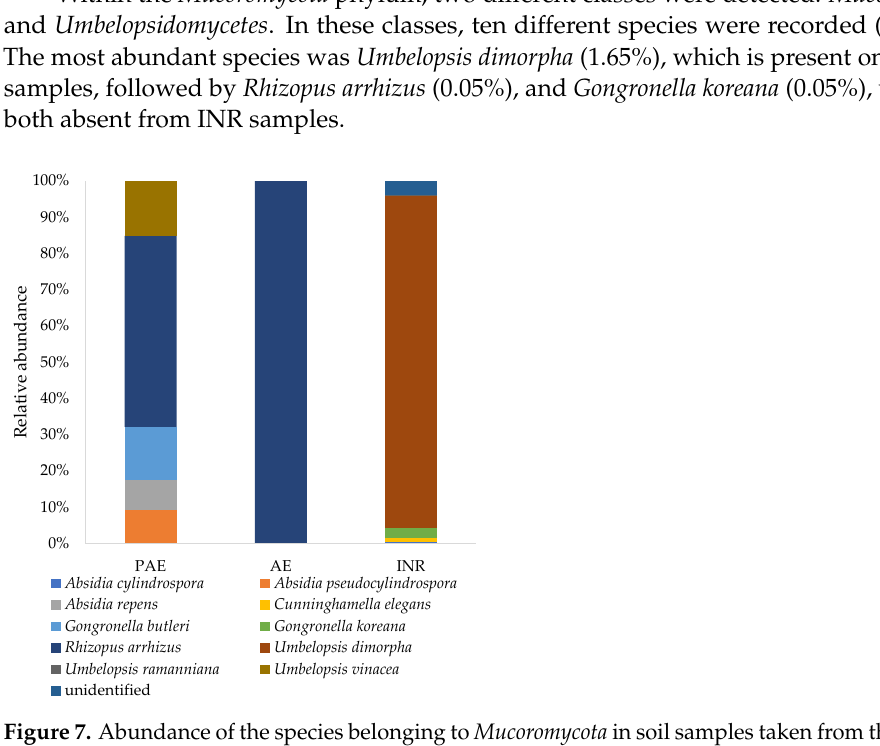
Table 4. Richness and diversity indices based on Illumina MiSeq sequencing fata (mean ± standard deviation) of soil samples taken from the integral natural reserve (INR), the polluted AgroEcosystem (PAE) and the AgroEcosystem (AE). Observed Species